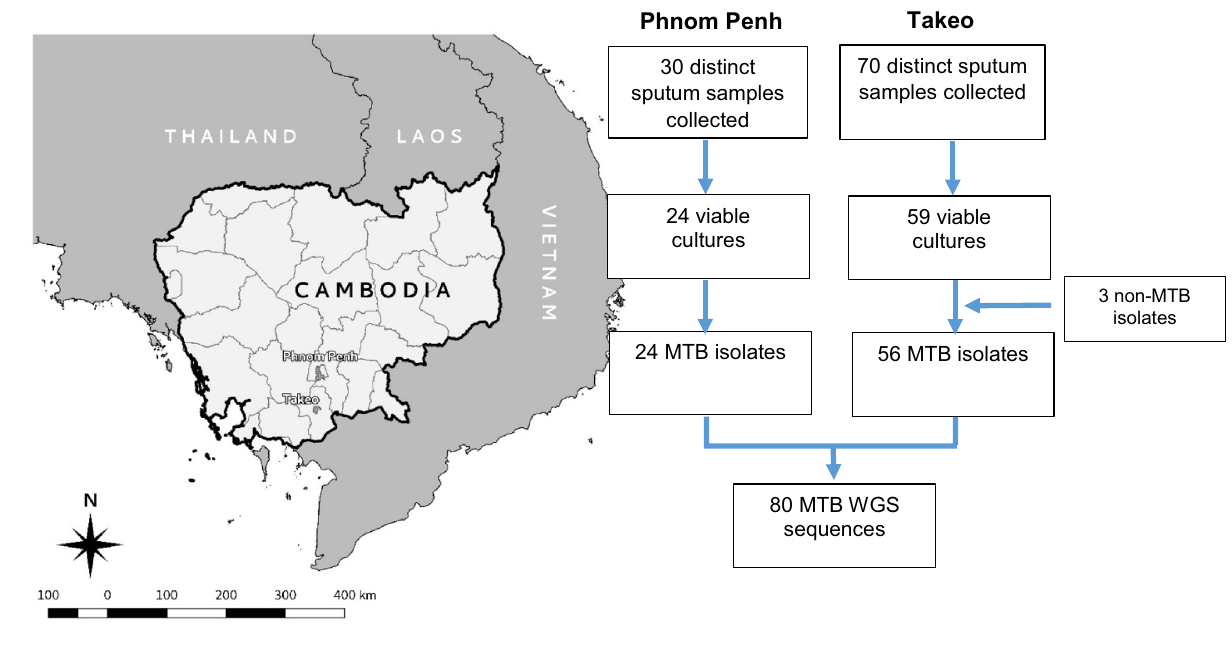
Figure 1. Map and flowchart illustrating the sampling collections of Phnom Penh and Takeo within Cambodia and number of samples collected. The map was created with QGIS software version 3.8.0 distributed